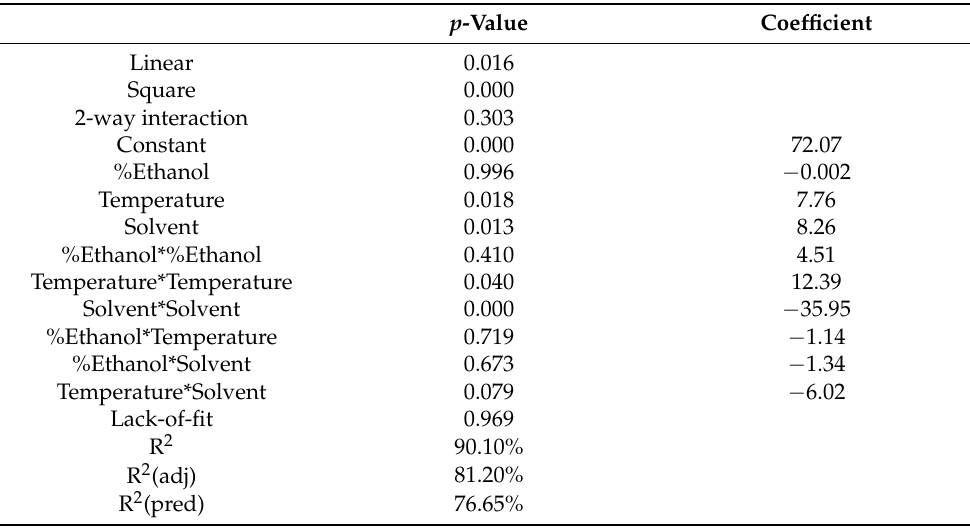
Table 3. ANOVA results for optimization of the extraction method using